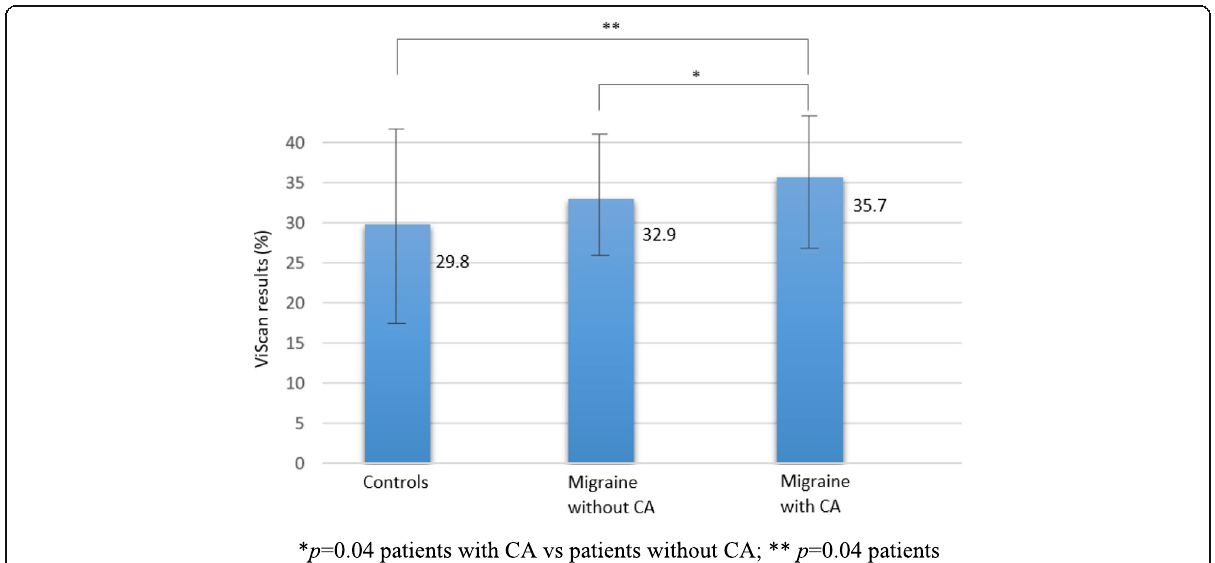
Fig. 1 Abdominal fat in patients with or without cutaneous allodynia. * p = 0.04 patients with CA vs patients without CA; ** p = 0.04 patients with CA vs controls; CA: Cutaneous allodynia